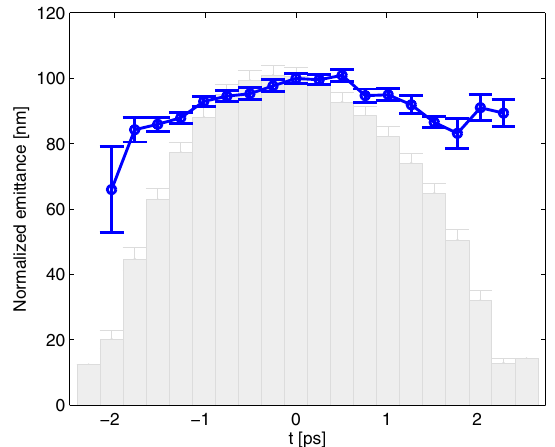
FIG. 9. Normalized slice emittance in the horizontal plane for a bunch charge of 10 pC (blue). The error bars are obtained by error propagation of the statistical beam-size errors. The longitudinal bunch charge profile is shown in gray